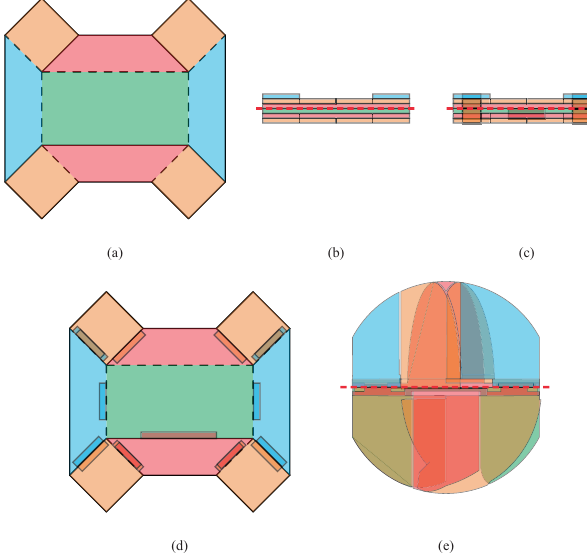
Figure 9. A schematic of the pattern used in the design of the fold- able sphere. (a) The crease pattern. (b) The panel stack and joint plane. (c) The panel stack with offsets. (d) The offsets shown with the open model. (e) The panel stack with offsets and modified panel